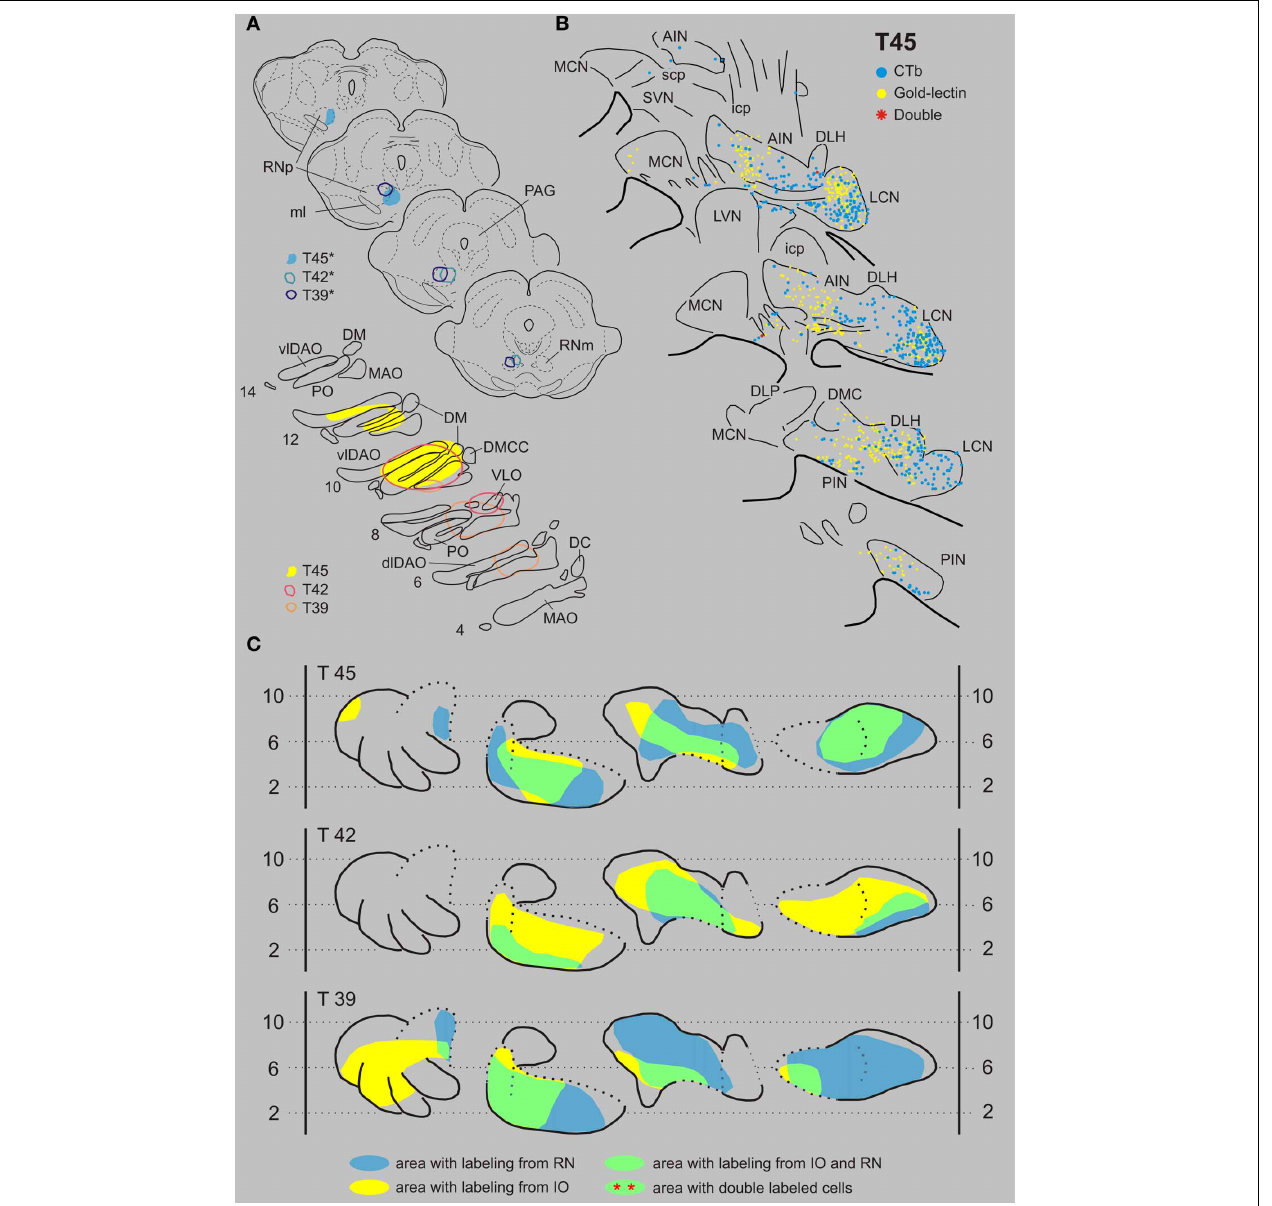
FIGURE 3 | Diagrams depicting results of the combination IO and RN. (A) Injection sites of all three analyzed cases. Upper left hand panels show the injection sites within transverse diagrams of the midbrain. Bottom panels show the related injection sites as placed in the left inferior olivary complex, depicted in standardized diagrams (adapted after Ruigrok and Voogd, 2000). In this combination all CTb injection sites (case number indicated with ∗ ) were made in the RN, while gold-lectin was injected in the IO. (B) Resultant plots of 5 equidistant (320 micron) sections (from caudal, bottom, to rostral, top) showing labeled neurons within the contralateral CN of case T45. Every symbol indicates a single labeled neuron. (C) Single and double-labeling of case T45 as well as from the other two cases (T42 and T39) indicated in standardized diagrams shown in Figure 1B . Areas containing retrograde labeling from the RN are indicated in blue, whereas labeling from the IO are indicated